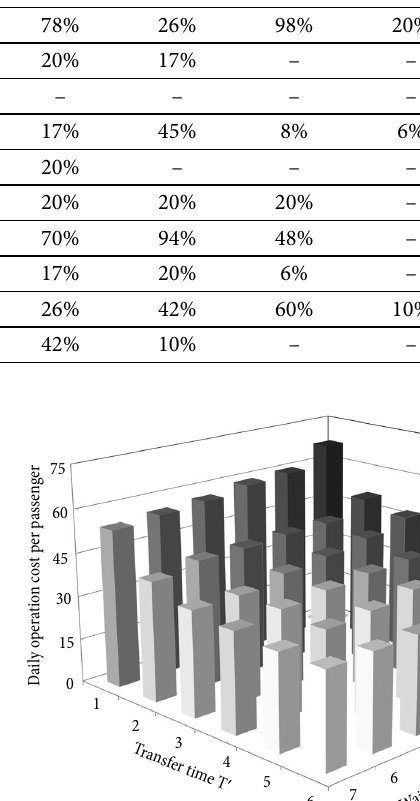
Table 3. Loading factor of Dalian airport coach ( T = 3, T ′ = 2) Route